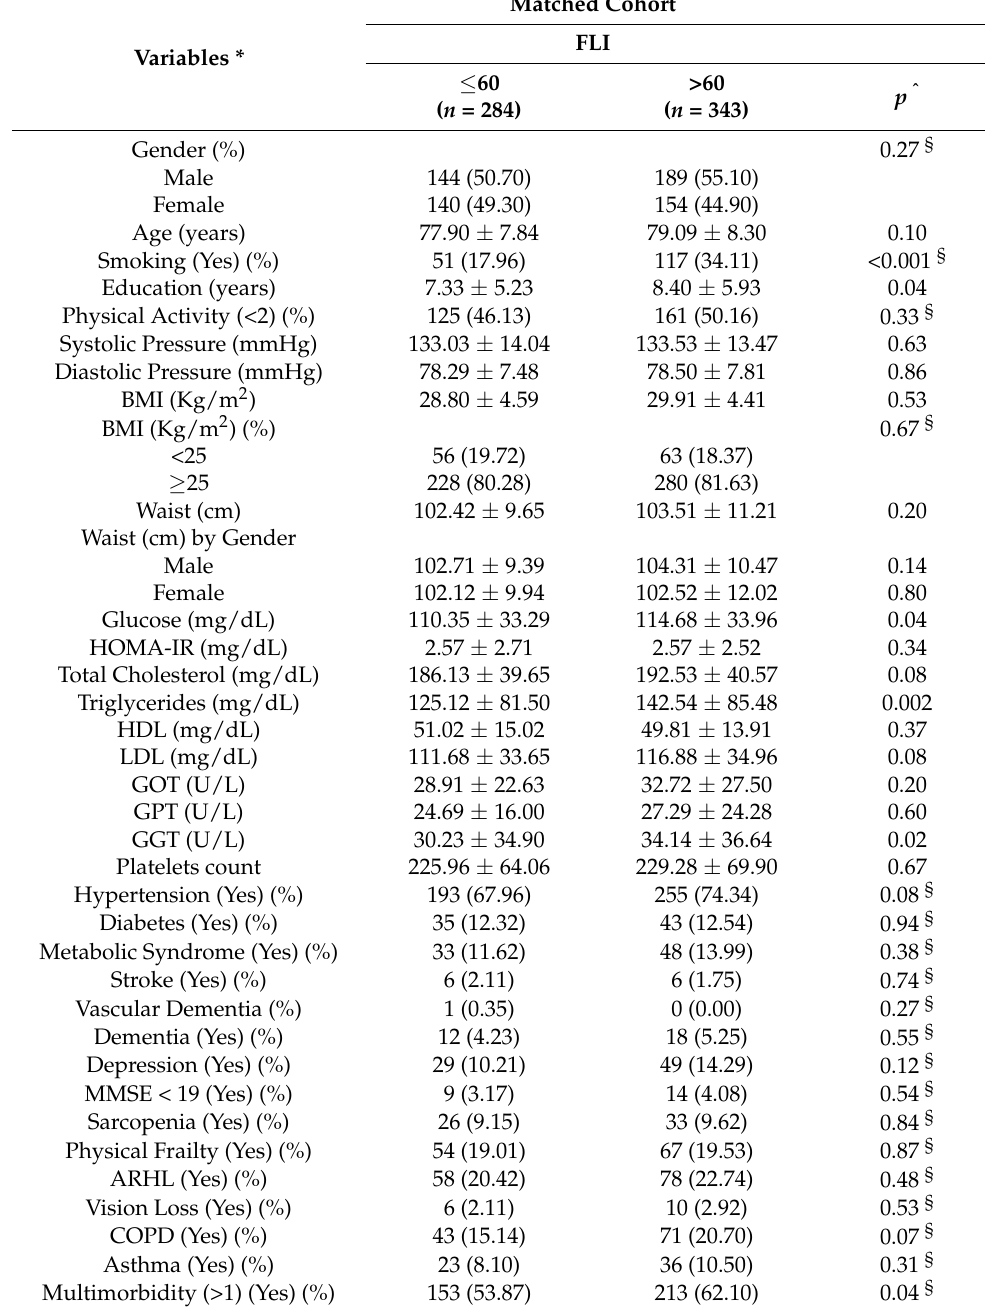
Table 4. Baseline and clinical characteristics of patients in the matched